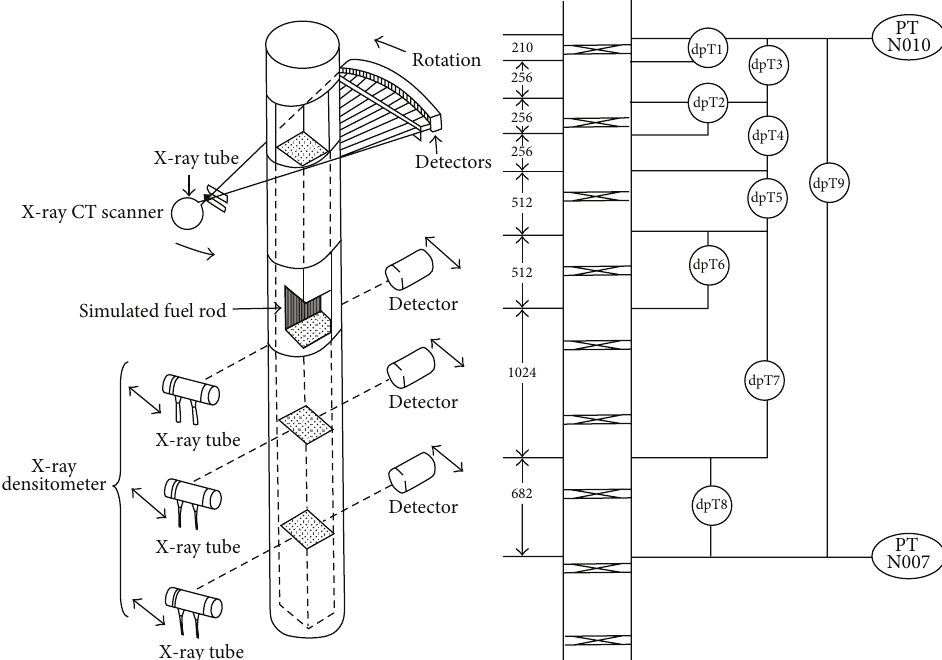
Figure 1: Void fraction and pressure drop measurement positions.